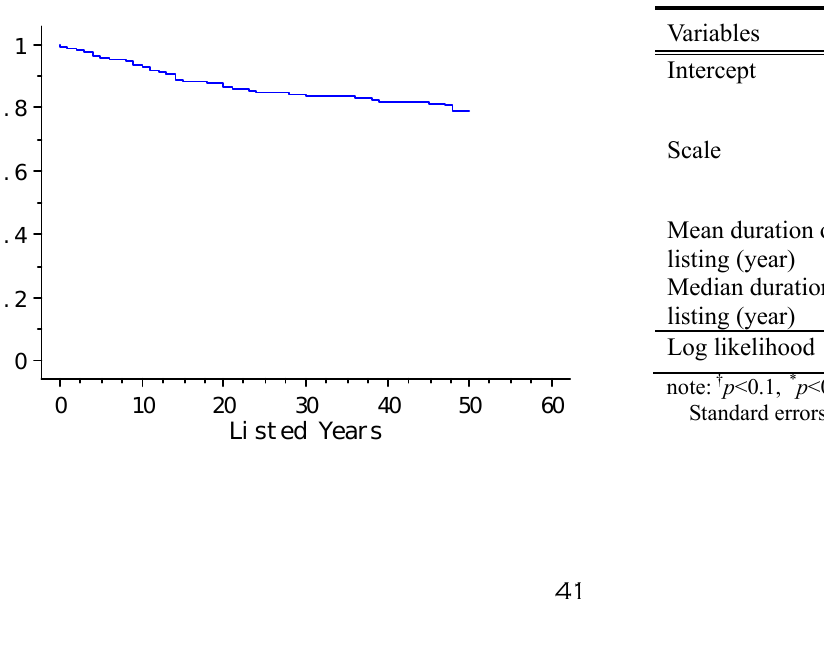
Figure 1. Kaplan-Meier Plot of the Listed